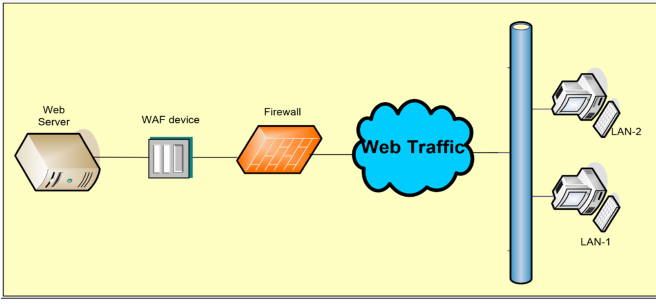
Figure 6. Reverse proxy and layer 2 bridge topology.